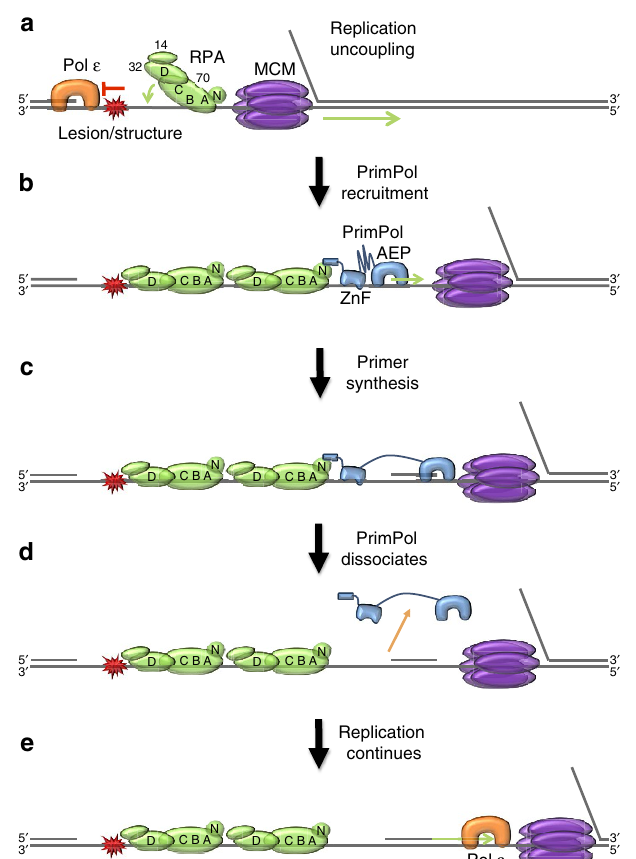
Figure 7 | Model for PrimPol recruitment to stalled replication forks by RPA. ( a ) Unrepaired DNA damage lesions, or DNA secondary structures, in the leading strand template lead to stalling of polymerase e . This causes uncoupling of replication, generating ssDNA downstream of the DNA damage lesion/structure and facilitating binding of RPA. Note that for simplicity other replisome components and lagging strand synthesis machinery are not shown. ( b ) PrimPol is recruited to the ssDNA interface uncovered by the replicative helicase through the interaction of its RBM-A with RPA70N. This interaction is stabilized by the binding of the ZnF and AEP domains to ssDNA. ( c ) PrimPol catalyses the synthesis of a new DNA primer, before further extension is prevented by the restraining effect of the RPA interaction and ZnF domain, coupled with the enzyme’s low processivity. ( d ) Unable to continue with primer extension, PrimPol dissociates from the template strand. Re-binding upstream is prevented by RPA. ( e ) The nascent primer is utilized by the replicative polymerase for continued DNA replication. This leaves behind a short RPA-coated ssDNA region opposite the lesion to be filled in by template switching or